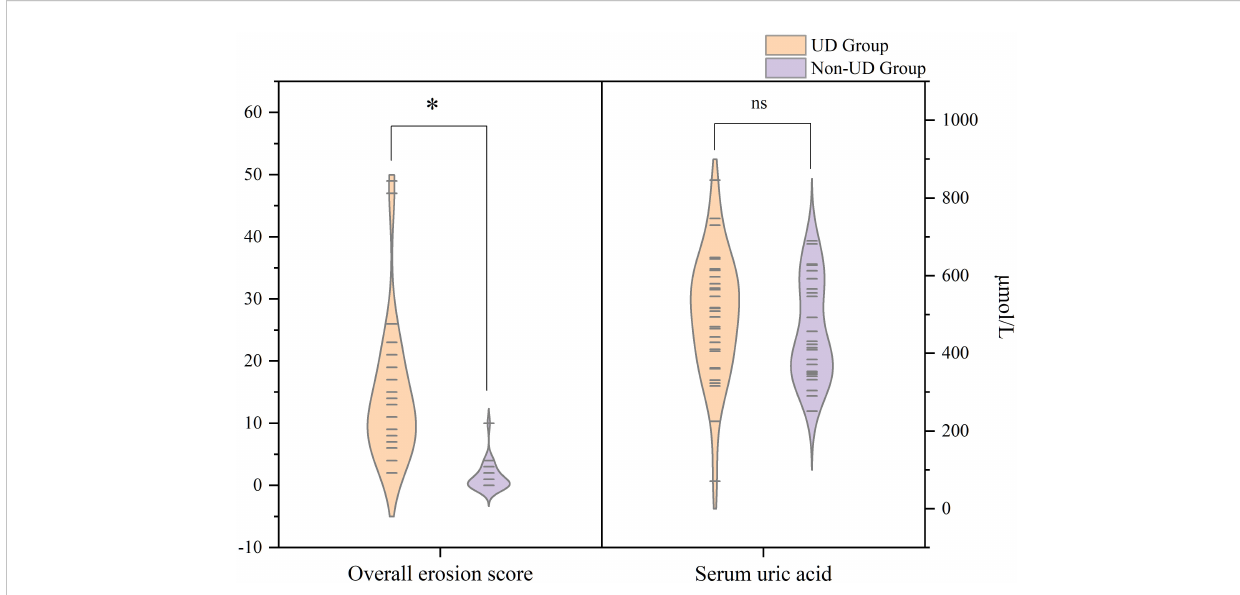
FIGURE 3 Differences between the UD and non-UD groups in the overall erosion score and serum uric acid. The modi fi ed SvdH erosion scores were signi fi cantly higher in the UD group than in the non-UD group (left), but serum urate level did not differ between the two groups (right). SvdH, Sharp/van der Heijde; UD, urate deposition.